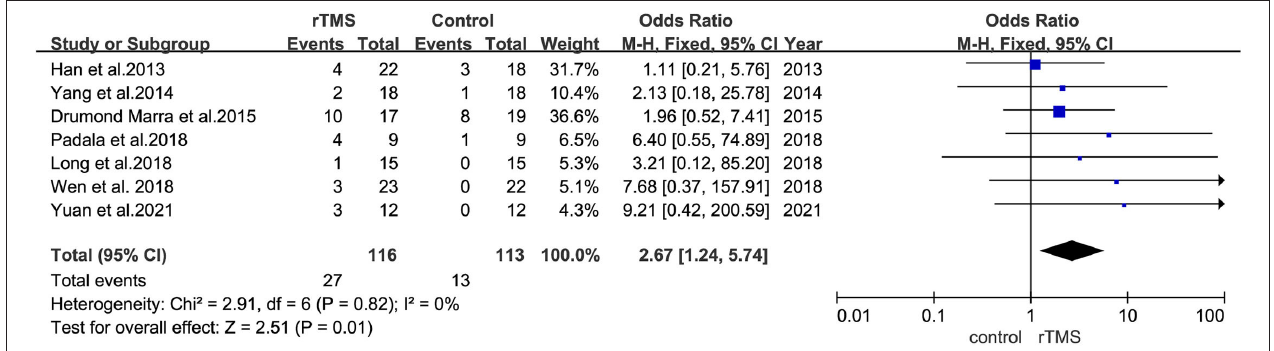
FIGURE 10 | A forest plot displaying results of subgroup analyses results for adverse